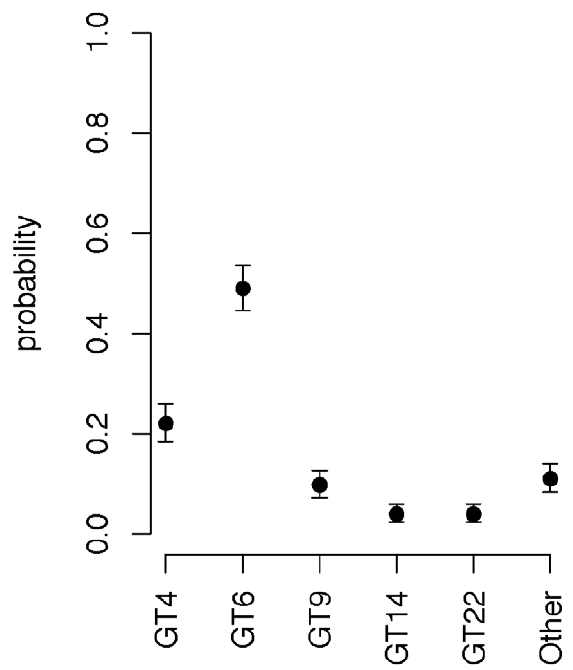
Figure 4. Median probabilities and 95% credible intervals for genotypes sampled from the Etosha National Park. GTs occurring # 5 times are pooled into the ‘‘Other’’ category.